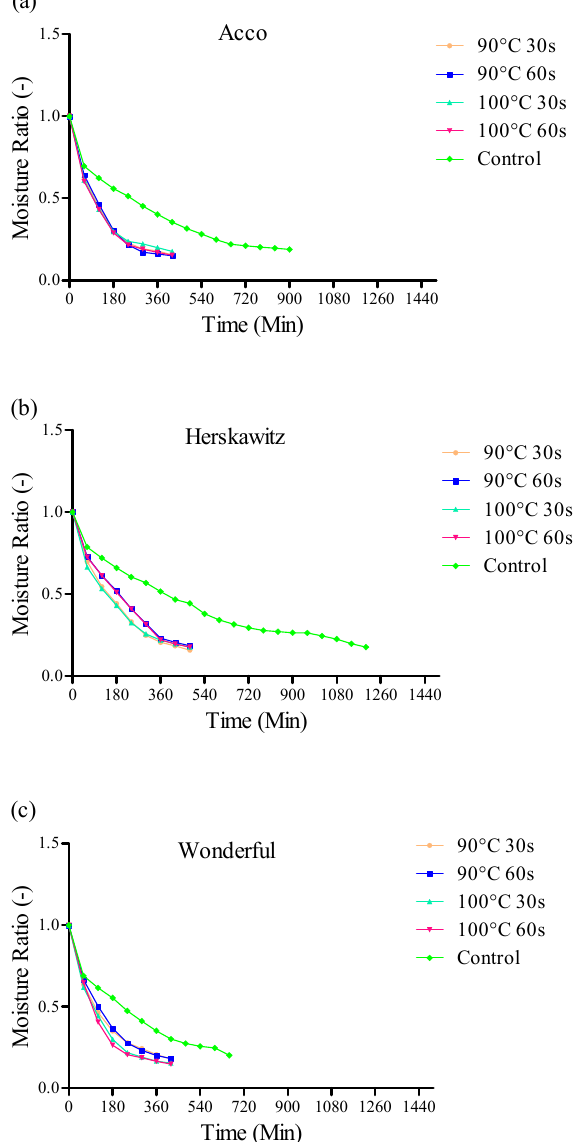
Figure 4. Drying curves for pomegranate aril cultivars ( a ) Acco, ( b ) Herskawitz and ( c ) Wonderful at